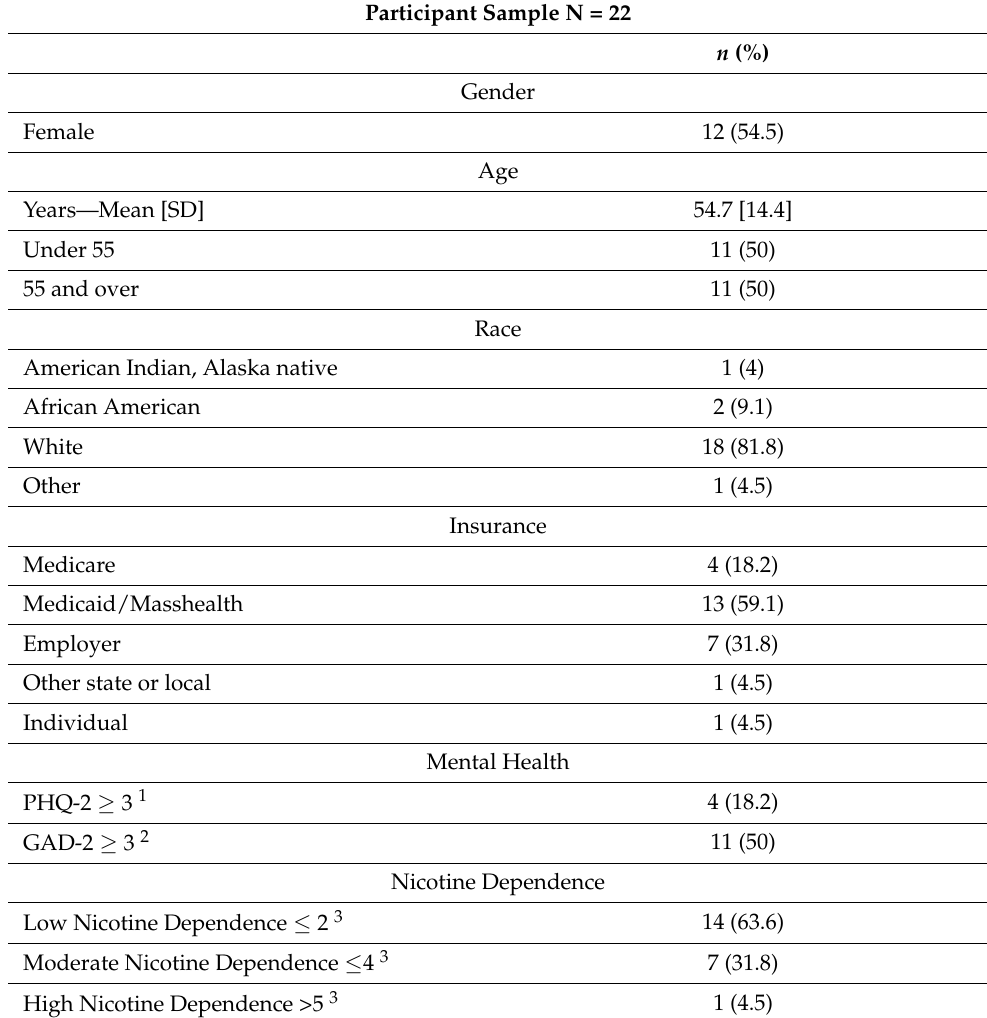
Table A1. Participant